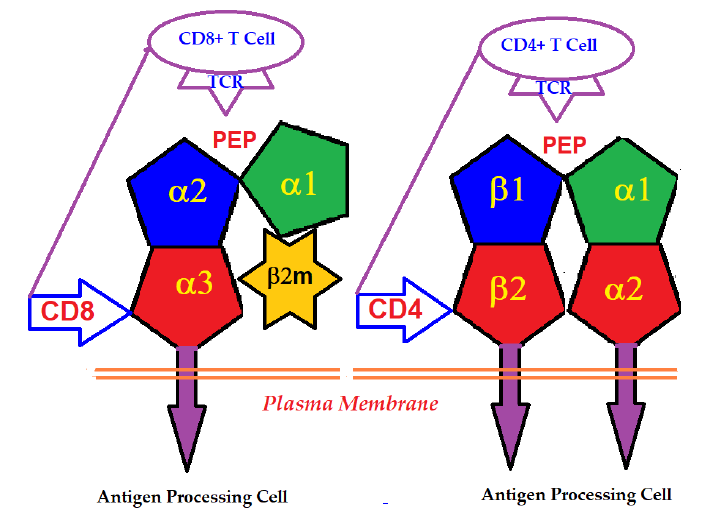
Figure 1. Binding of T-cell co-receptors CD8 and CD4 to α 3-domain of HLA-I and β 2-domain of HLA-II, respectively.